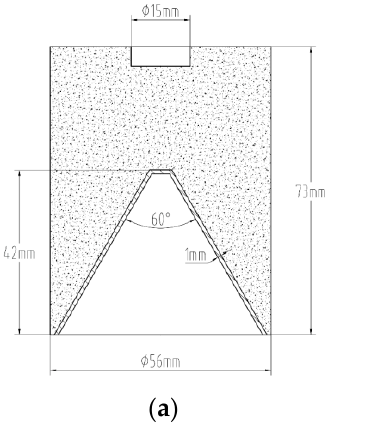
Figure 2. SCJ warhead. ( a ) Dimensions of the warhead; ( b ) OFHC-Cu liner; ( c ) Pure Mo liner.